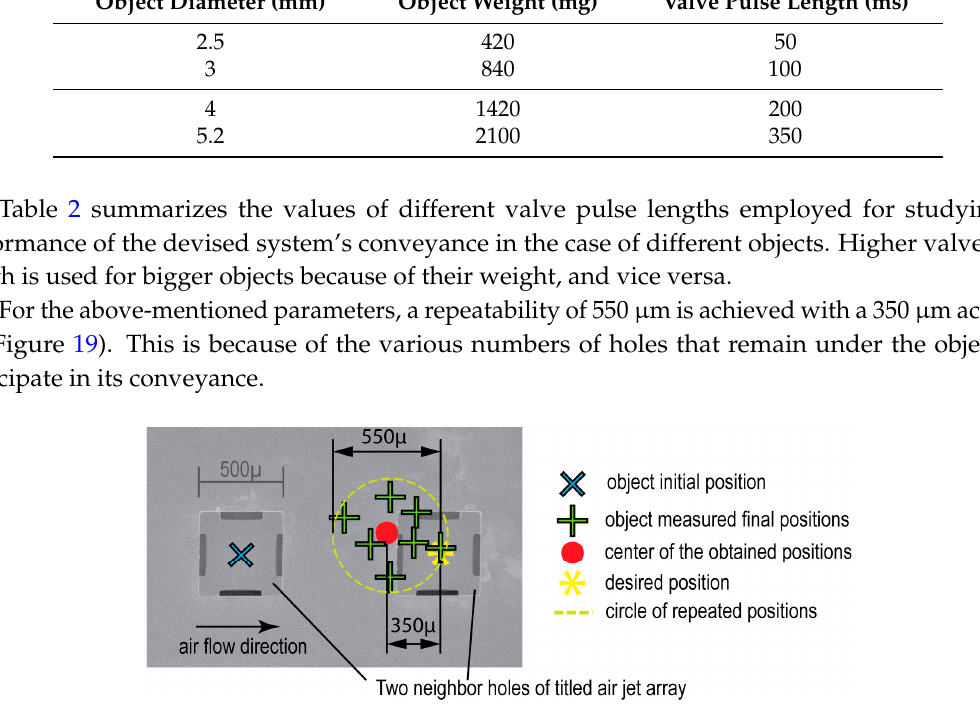
Table 2. Solenoid valve pulse length regulation for different object sizes and weights.